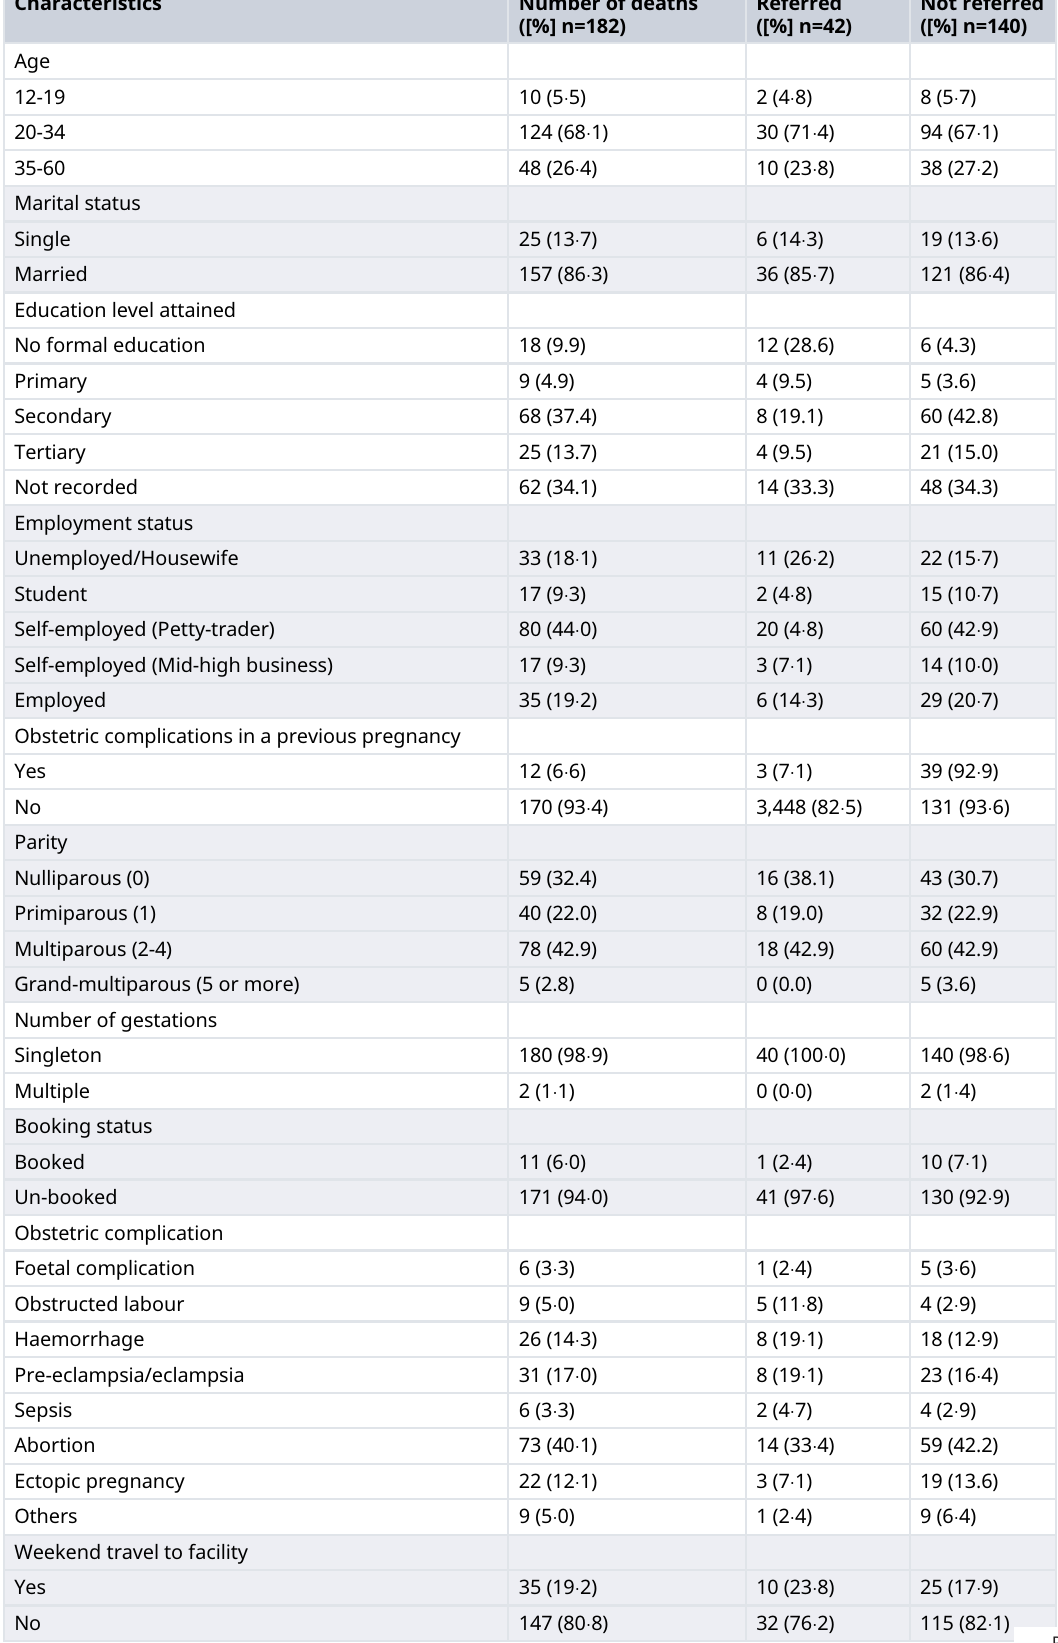
Table 1. Socio-demographics, obstetric history, characteristics of index pregnancy, and travel to care for pregnant women who ended in maternal deaths.